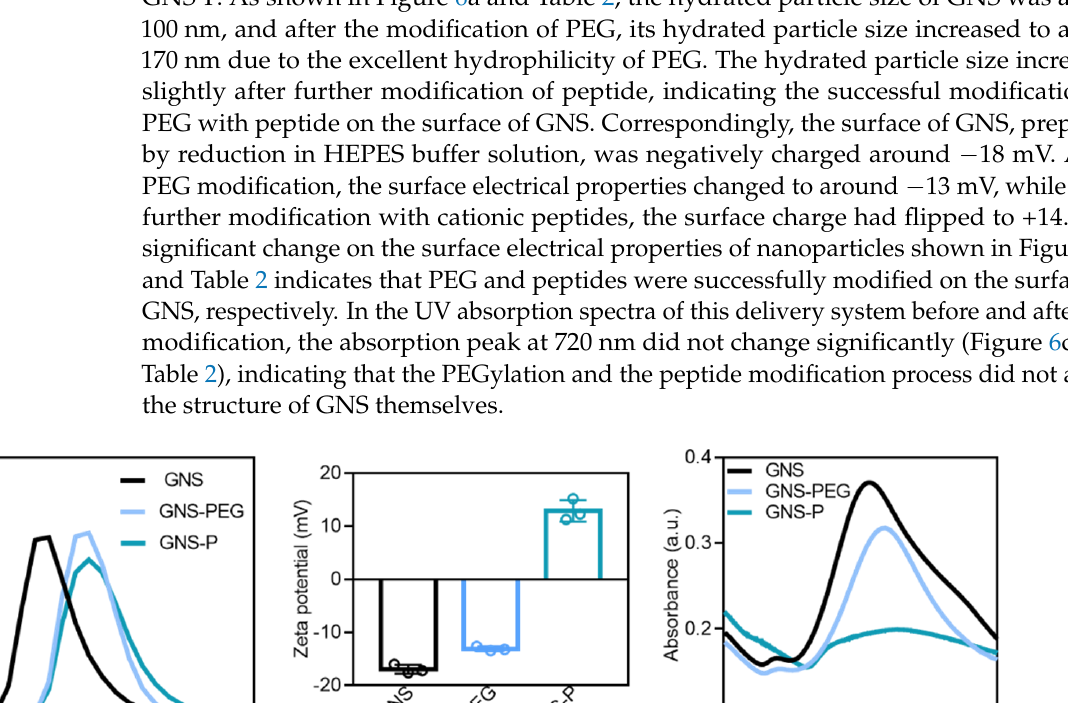
Figure 5. Optimization of the adsorption performance of GNS on siRNA analyzed by agarose gel electrophoresis.